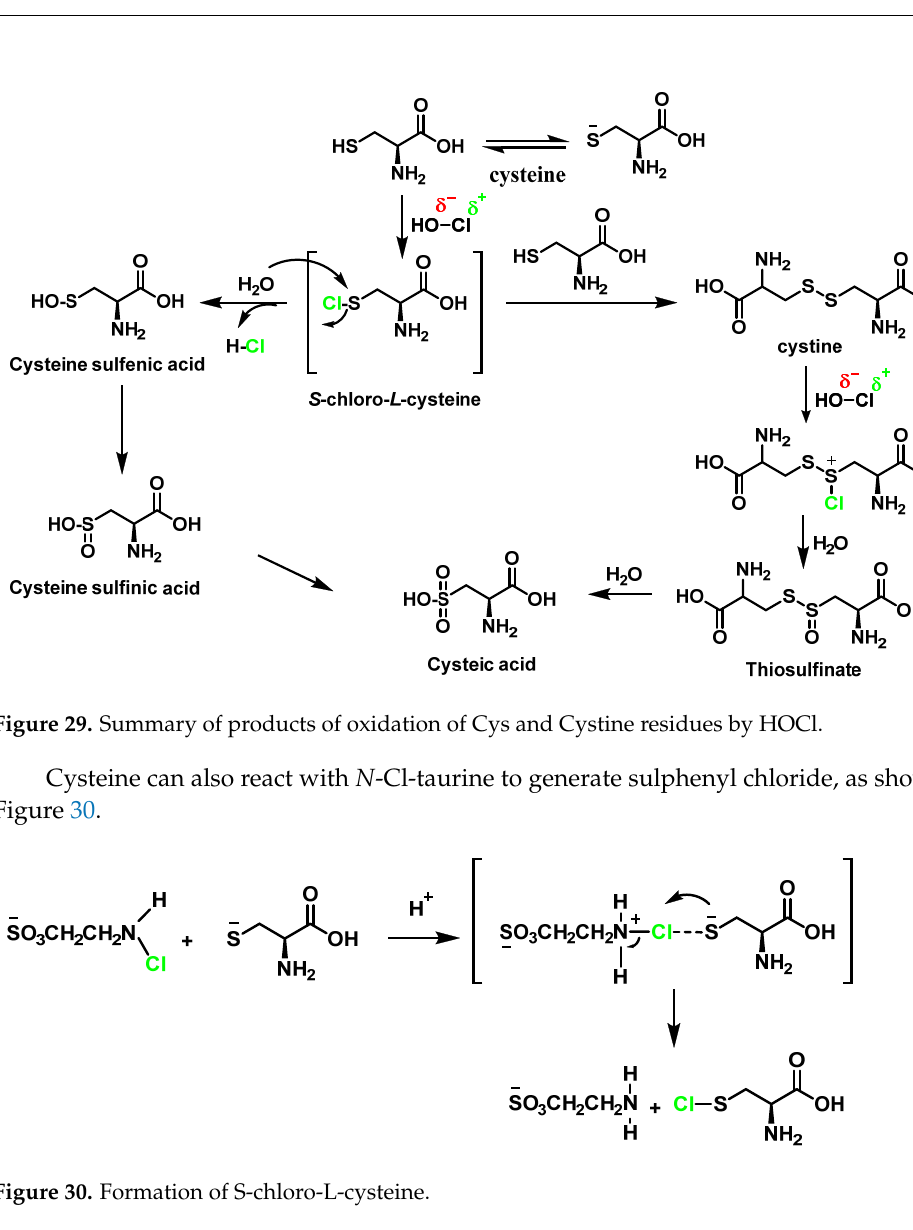
19 of 46 Figure 28. Proposed structures of chlorinate L-arginine products. 6.3. Reaction of HOCl with SULFUR-Containing Amino Acids HOCl and reacts extremely rapidly (k ≈ 3107 M − 1 s − 1 ) with sulphur-containing resi- dues (cysteine and methionine) [75,80]. The thiol functional group of the amino acid cys- teine can undergo a wide range of oxidative modifications. The thiol group of cysteine reacts with HOCl and through the formation of an unstable sulphenyl chloride which un- dergoes various reactions with nucleophilic reagents can react with water to form a sul- phenic acid Cys-SOH [73,78,81]. Most sulphenic acids are highly unstable, with a half-life